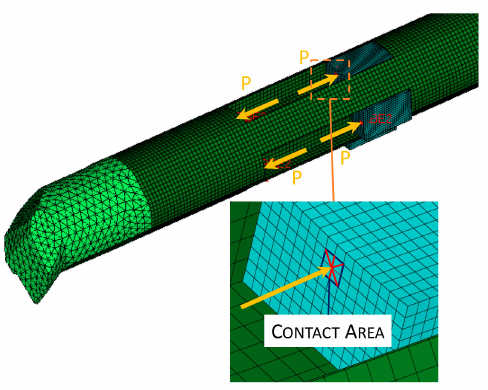
Figure 15. Boring Bar Finite Element model for sti ff ness estimation.